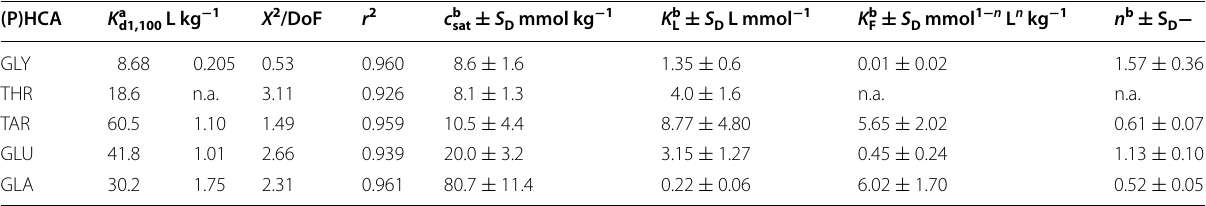
S D , standard deviation; n.a., not applicable